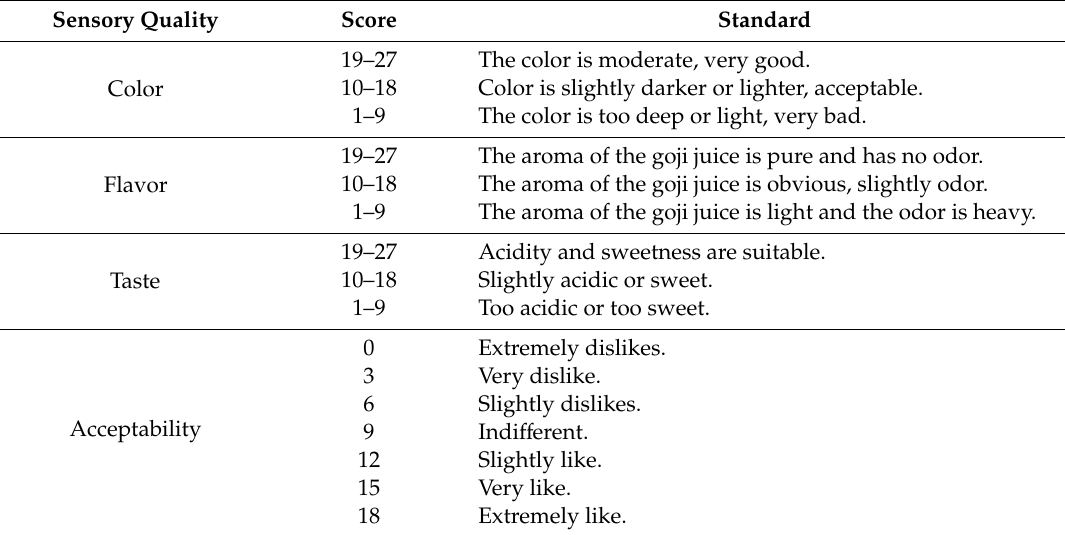
Table 5. Standard of sensory quality for fermented goji